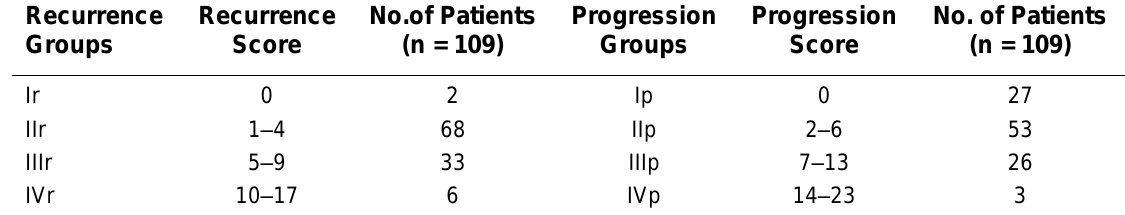
Patient Groups as per Final Recurrence and Progression Scores in the Study Population